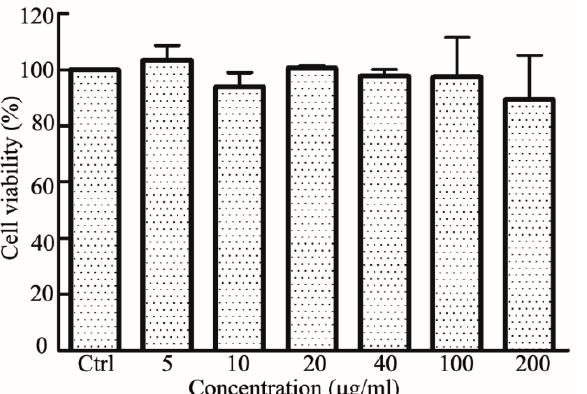
Figure 5. Cytotoxicity assessment of RES-PCAC-NPs at different concentrations on RAW 264.7 mac- rophages.